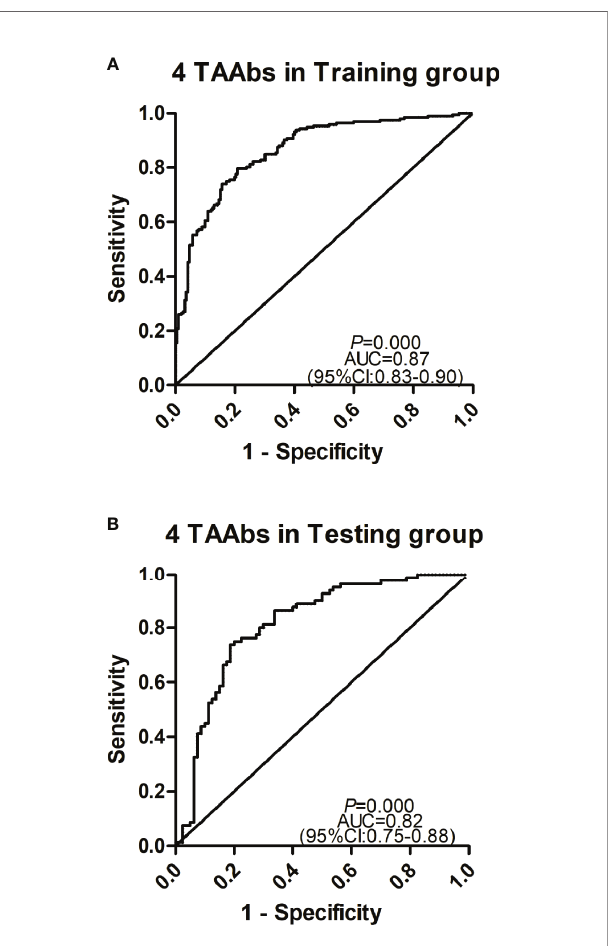
FIGURE 5 | Receiver operating characteristic curve analysis of the prediction model with TAAbs panel in gastric cancer (GC) detection. (A) The prediction